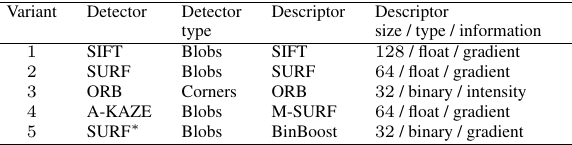
Table 1. The keypoint detector-descriptor combinations involved in our